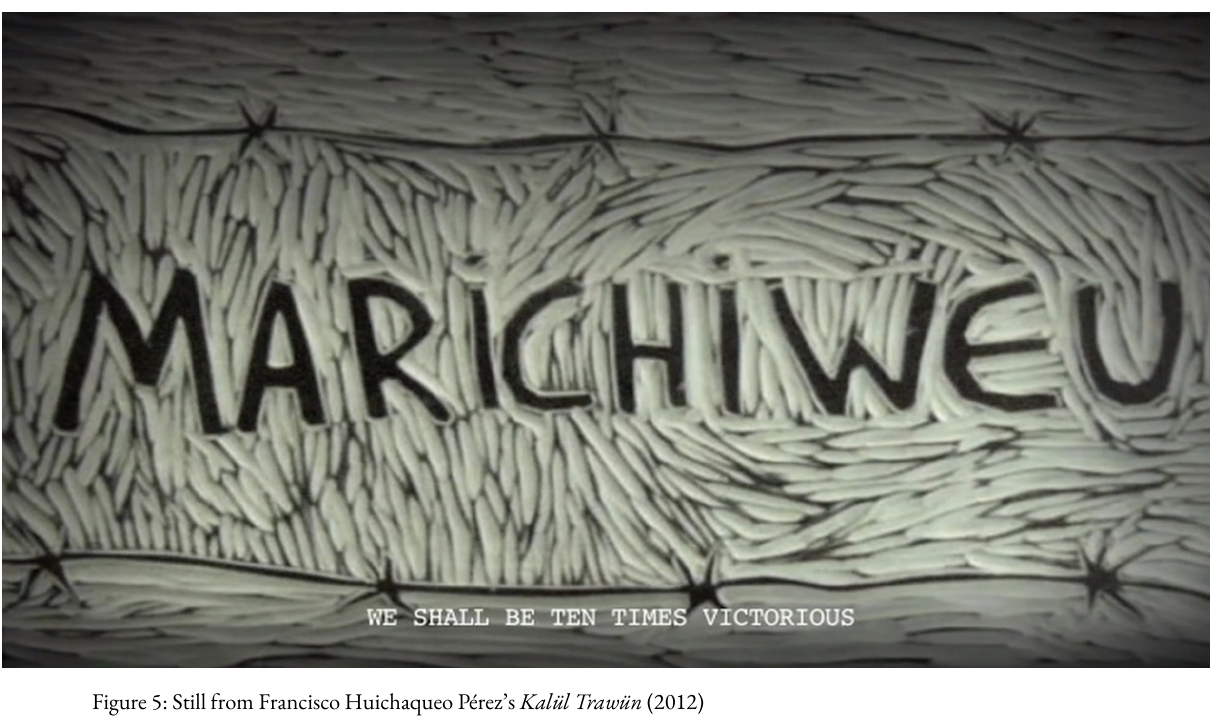
Figure 5: Still from Francisco Huichaqueo Pérez’s Kalü l Trawü n (2012) Video still courtesy of Francisco Huichaqueo Pérez. Film available at: https://vimeo.com/